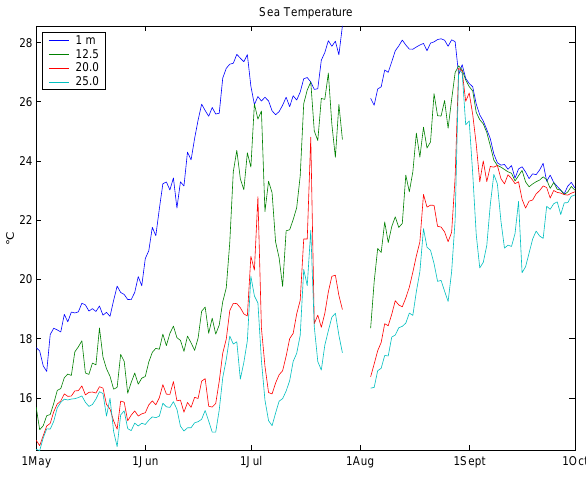
Fig. 5. Daily averaged time series from May to September 2003 of the sea temperature at four depth levels at the SAMA-MAMBO coastal site.